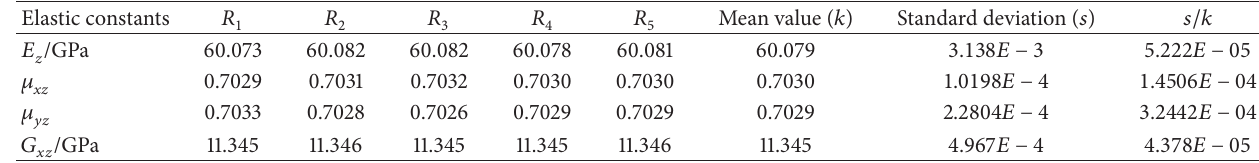
Figure 6: Deformation of the FEM. Table 4: Effect of the random distribution of the void defects on the elastic